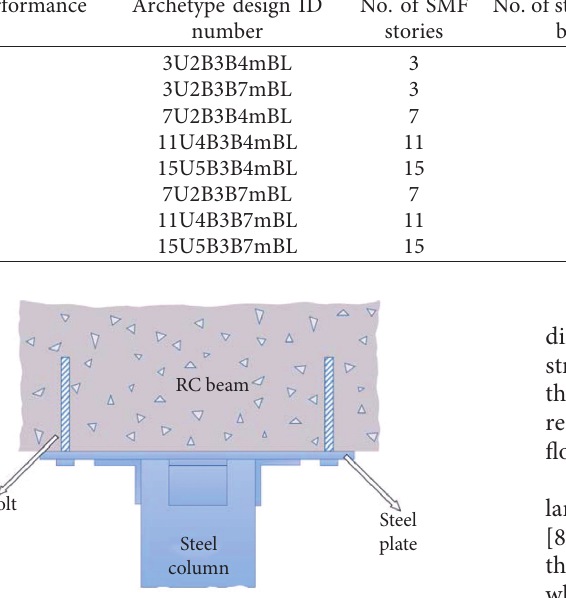
Figure 1: Schematic diagram of simple connections of steel col- umns in RCN